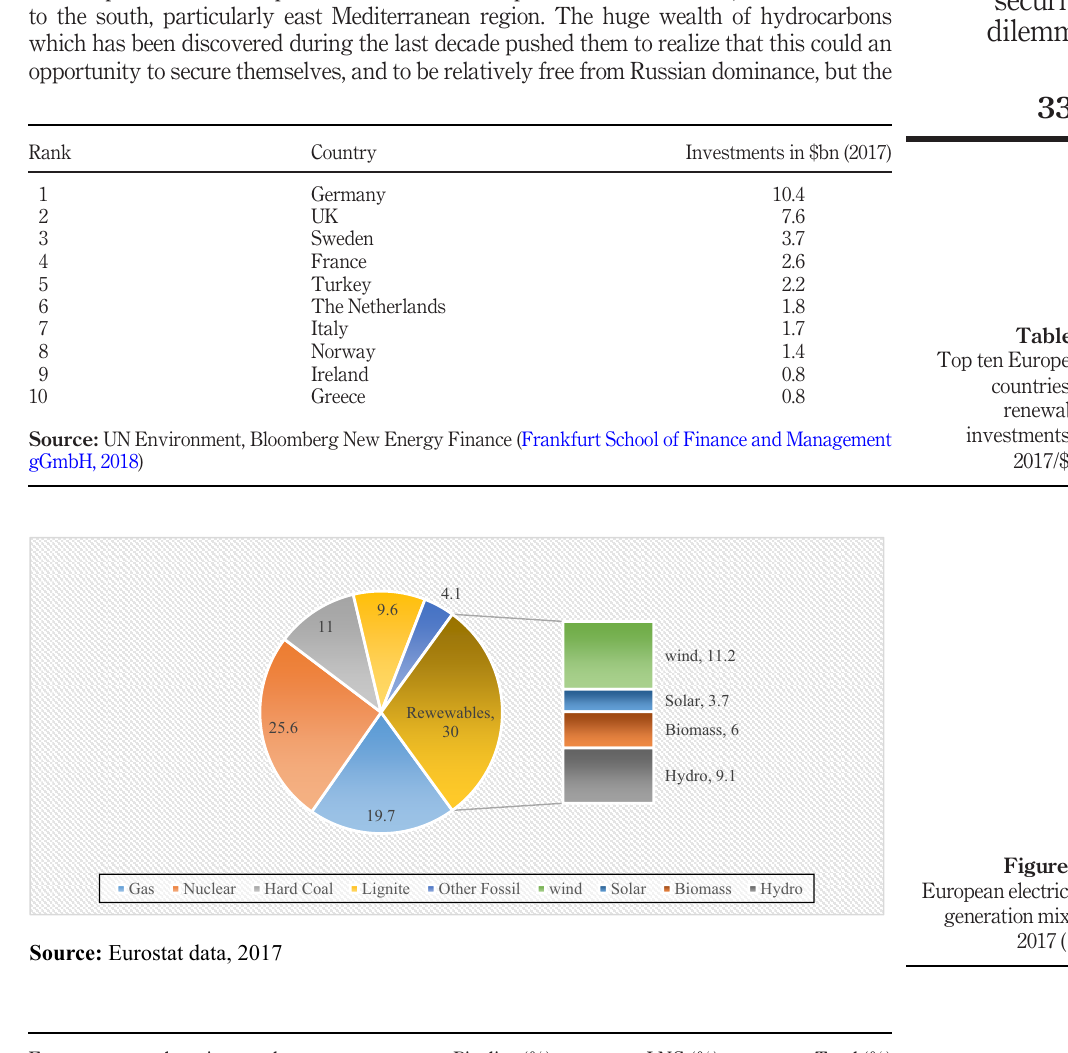
Table II. European imports